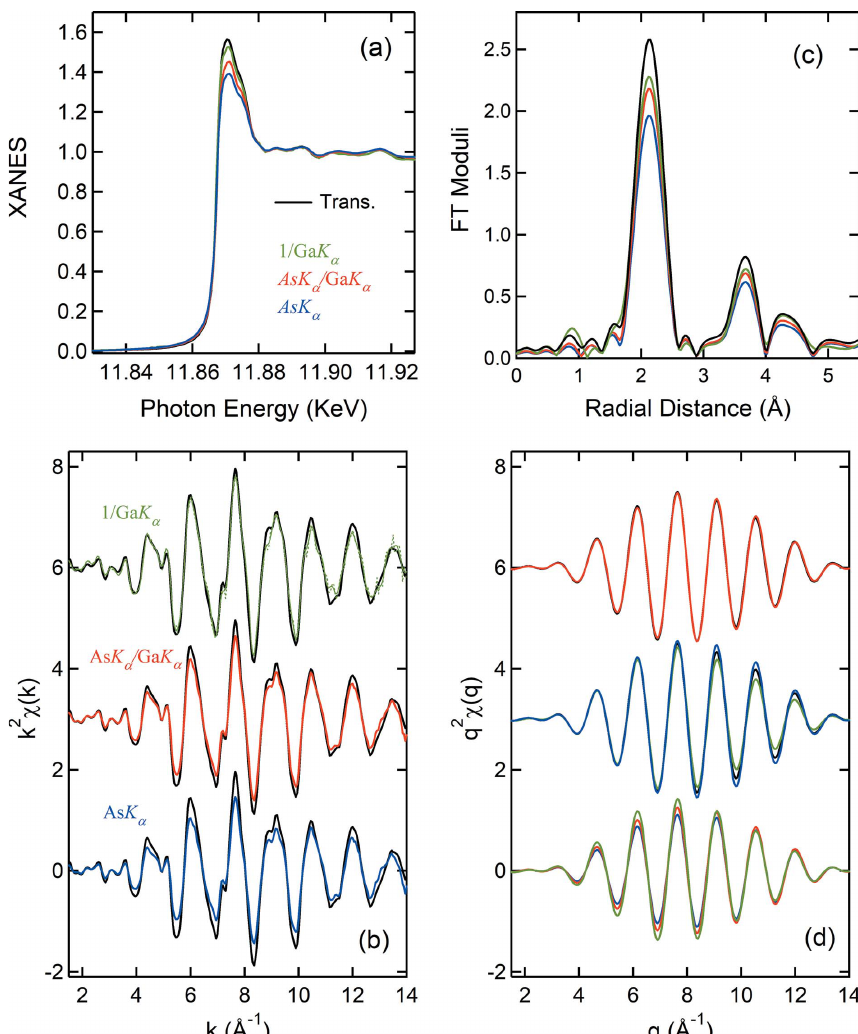
Figure 6 XAS spectra measured on GaAs powder, simultaneously, through the As K (cid:5) , Ga K (cid:5) and absorption channels at the As K -edge. ( a ) Normalized XANES. ( b ) Fluorescence EXAFS spectra compared with absorption EXAFS. The noise-filtered 1/Ga K (cid:5) data are also shown (full green line). The FT filter cut-offs are k = 0–14 A˚ (cid:6) 1 and R = 0–10 A˚ . ( c ) The FT moduli of the EXAFS spectra ( k = 3– 12.4 A˚ (cid:6) 1 , Hanning window). ( d ) The first-shell EXAFS obtained by the back FTs ( R = 1.6–2.6 A˚ ). Lower: As K (cid:5) (blue), 1/Ga K (cid:5) (green), and As K (cid:5) /Ga K (cid:5) (red). Middle: As K (cid:5) and 1/Ga K (cid:5) scaled to the standard in the low- k region. Upper: As K (cid:5) /Ga K (cid:5) data scaled to the standard by (cid:5)